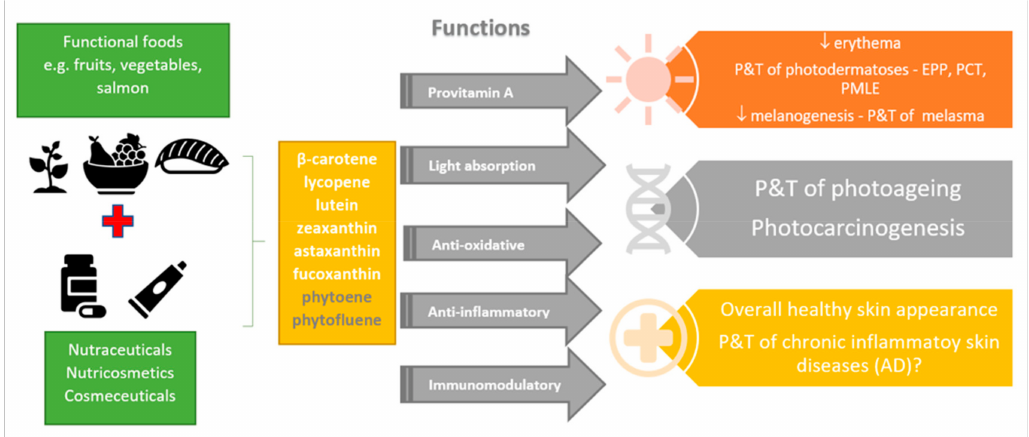
Figure 1. Diverse skin health-promoting e ff ects of food rich in carotenoids or their supplementation through nutraceuticals or cosmeceuticals. P&T, prevention and treatment; EPP, erythropoietic protoporphyria; PCT, porphyria cutanea tarda; PMLE, polymorphous light eruption; AD, atopic